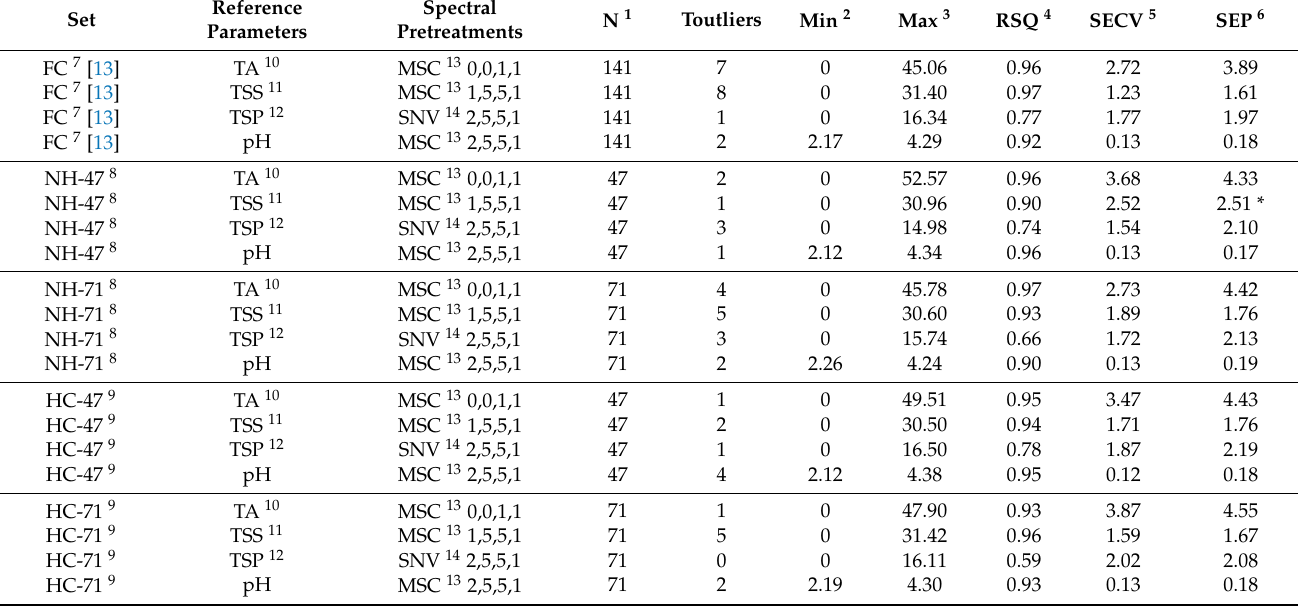
Table 2. Main statistical parameters for the MPLS calibrations developed for comparing the different sample selection methods. In the SEP column, asterisks (*) indicates statistically significant differences ( α = 0.05%) with the corresponding FC